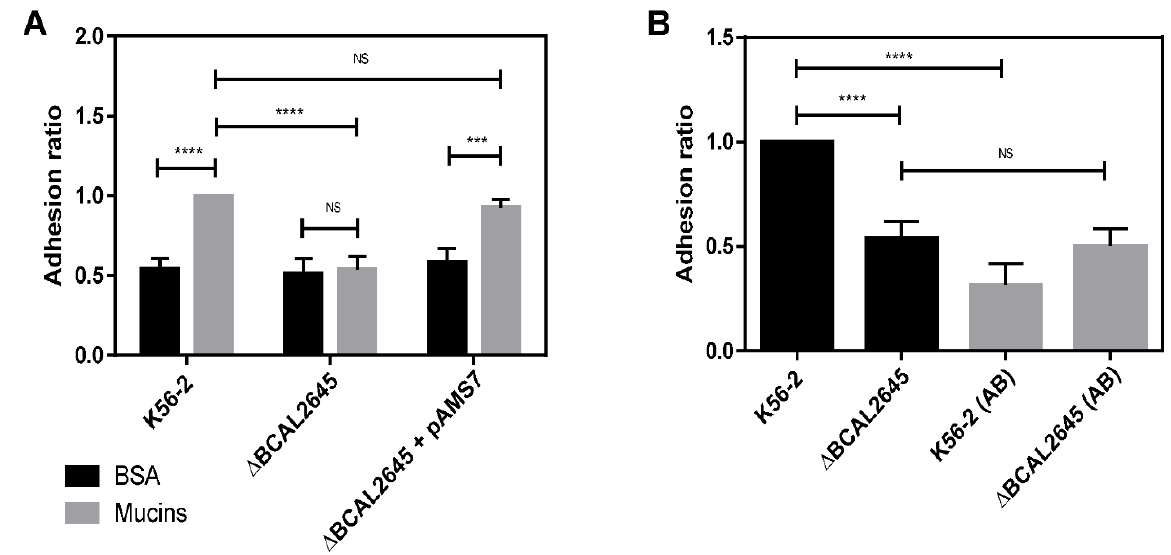
Figure 3. B. cenocepacia K56-2 and Δ BCAL2645 strain adherence to mucins and effect of the antibody anti-BCAL2645 on mucin adhesion in vitro. ( A ) Adherence of B. cenocepacia K56-2, Δ BCAL2645 strain and the mutant strain complemented with the BCAL2645 gene to BSA (negative control) and mucins. The assays comprised the coating of 96-wells ELISA plates with a solution of mucins or BSA (negative control) with a bacterial incubation period of 1 h. ( B ) Adherence to mucins by the WT strain and the mutant strain after incubation for 1 h with the anti-BCAL2645 antibody (AB) at a concentration of 0.125 mg/mL. Results are expressed as the percentage expressed as a ratio of B. cenocepacia K56-2 adherence to mucins. All the results are from at least three independent experiments, and bars indicate SD. (****, p < 0.0001; ***, p < 0.001, NS, non-significant).